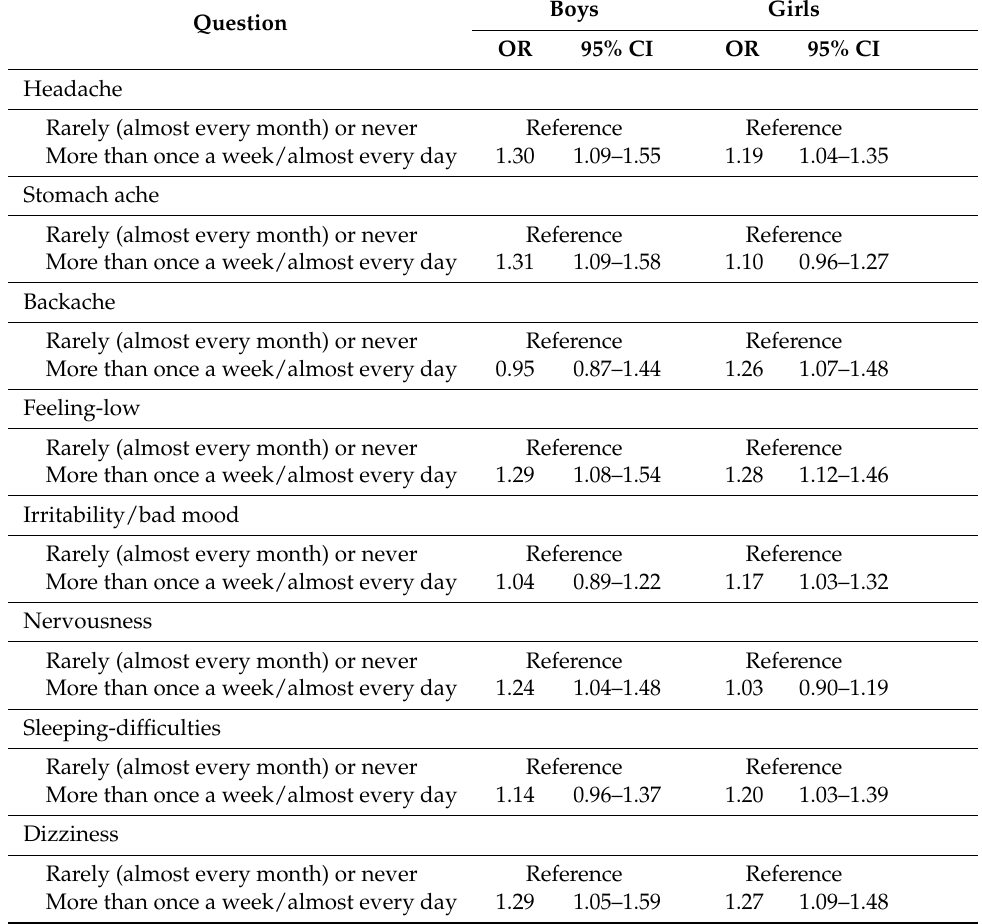
Table 4. OR and 95% CI for “sometimes symptoms (more than once a week/almost every day)” of self-perceived health according to low cardiorespiratory fitness (unhealthy) in a sample of schoolchildren from Bogot á , Colombia. The FUPRECOL